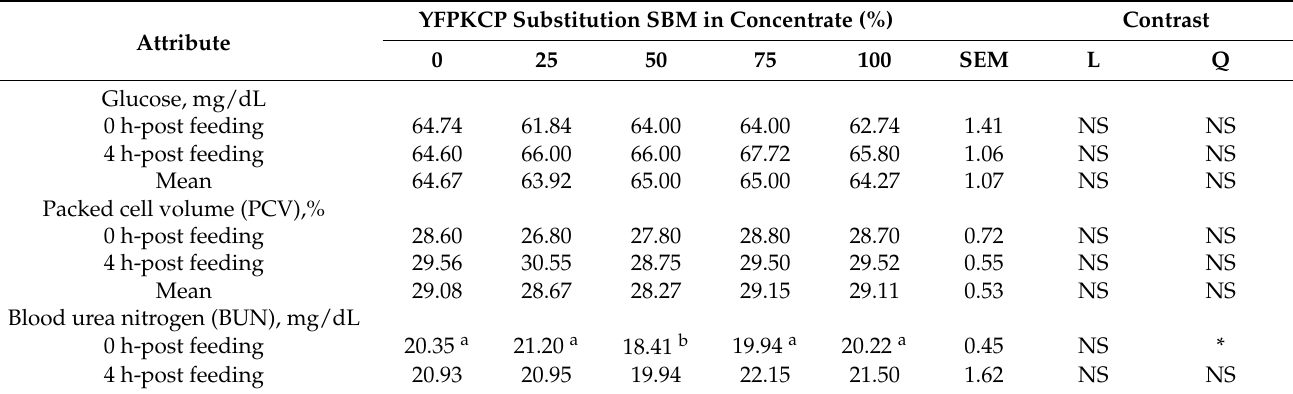
Table 7. Blood metabolized characteristics in goats fed fermented palm kernel cake diet.